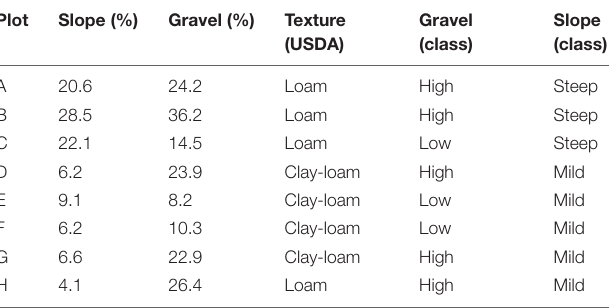
TABLE 1 | Summary of soil properties in the experimental field